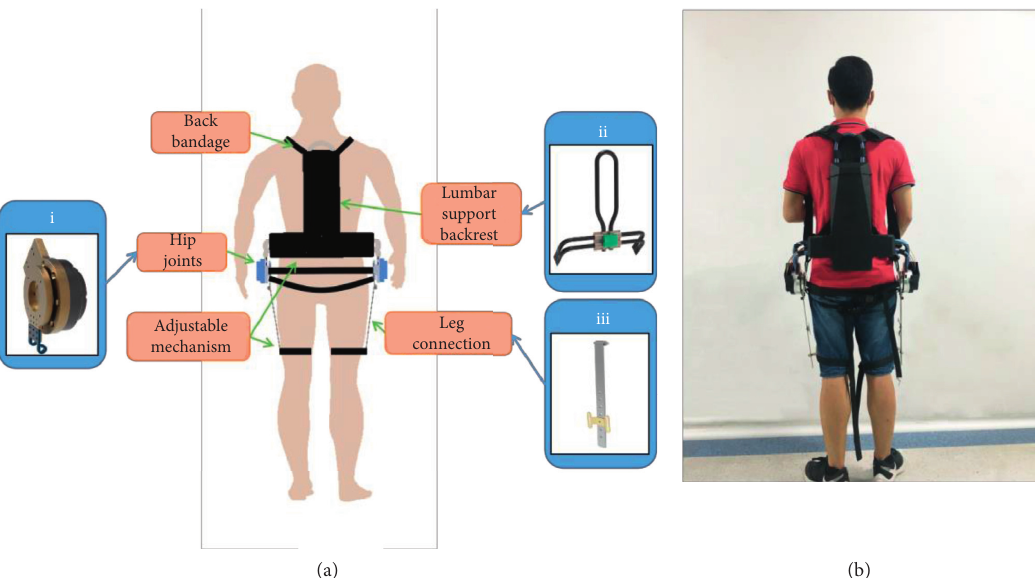
Figure 4: (a) The overall mechanical structure of SIAT-WEXv2: (i) structure model of hip joints; (ii) structure model of lumbar support backrest; (iii) structure model of leg connections. (b) Prototype of SIAT-WEXv2.